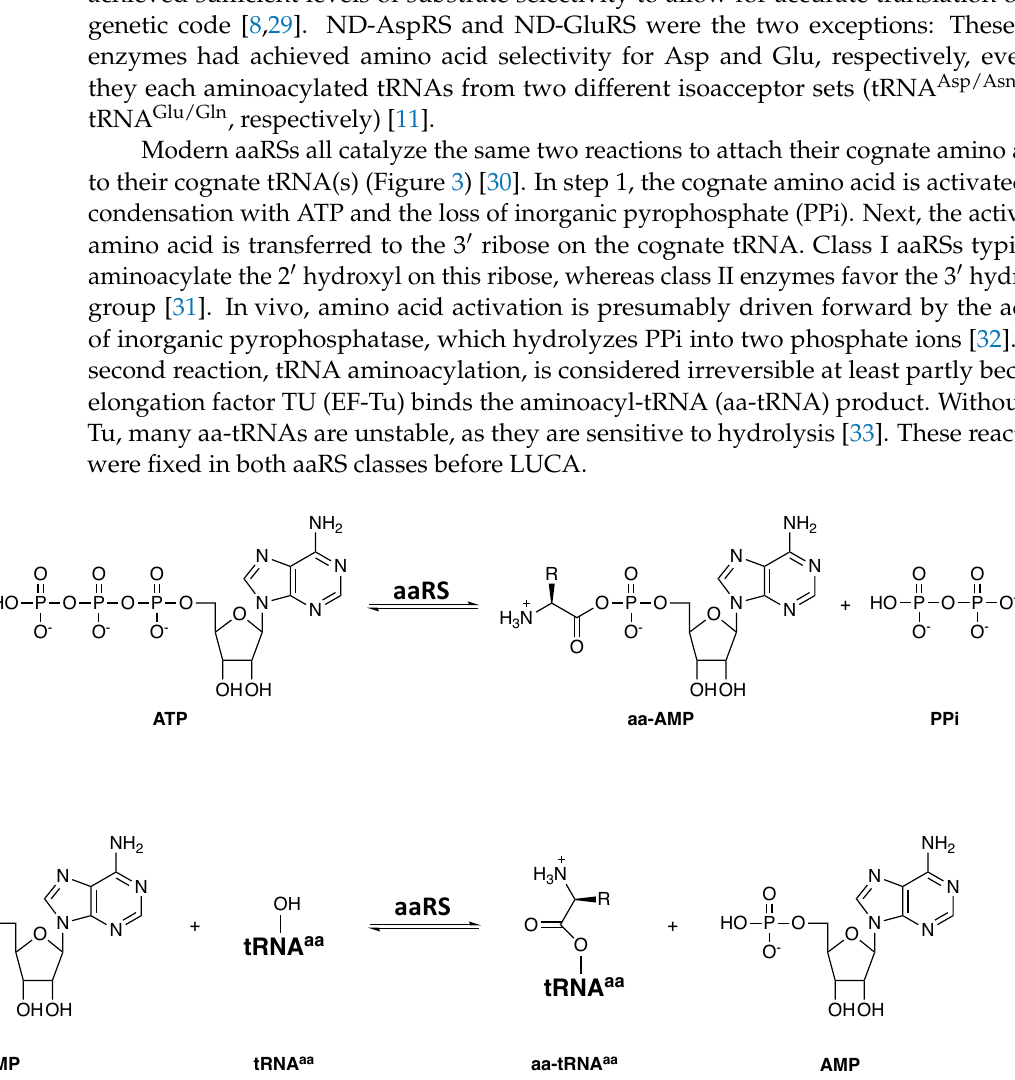
Figure 3. Reactions catalyzed by all known aaRSs. ( A ) Amino acid activation. ( B ) tRNA aminoacylation. Aminoacylation occurs on either the 2 (cid:48) or the 3 (cid:48) hydroxyl group of the 3 (cid:48) ribose on the tRNA. For clarity, only a single hydroxyl group is